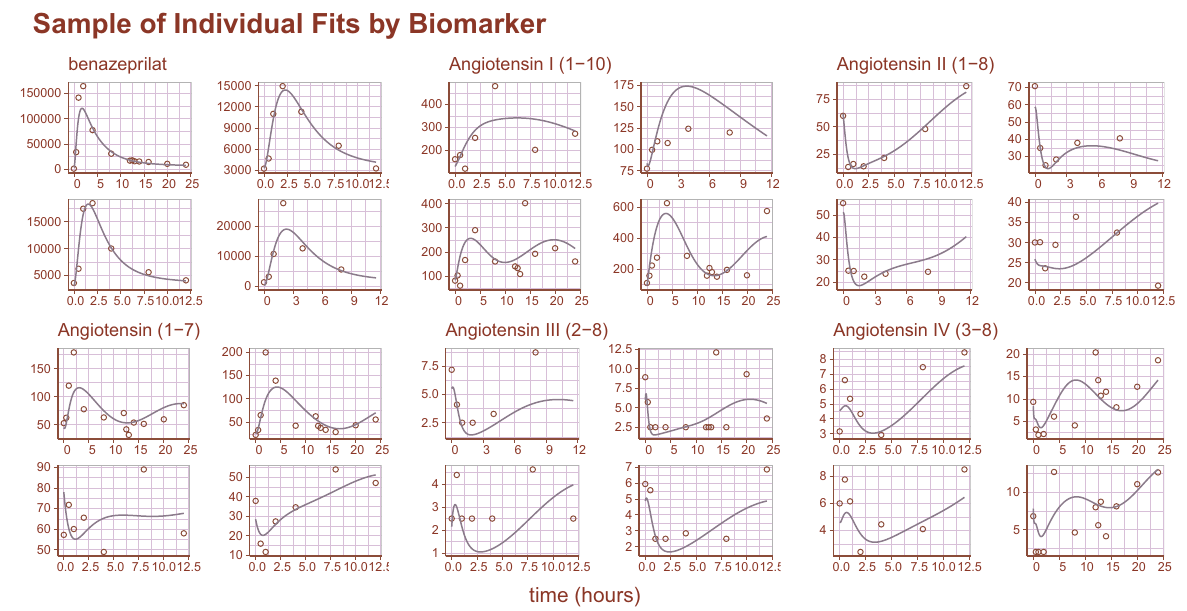
Figure 5. Sample of individual predictions. A sample of individual observations vs predictions randomly sampled from the concentration and metabolite data. The general agreement between plasma concentration time-course and individual predictions indicates that the model reproduces the observations with high